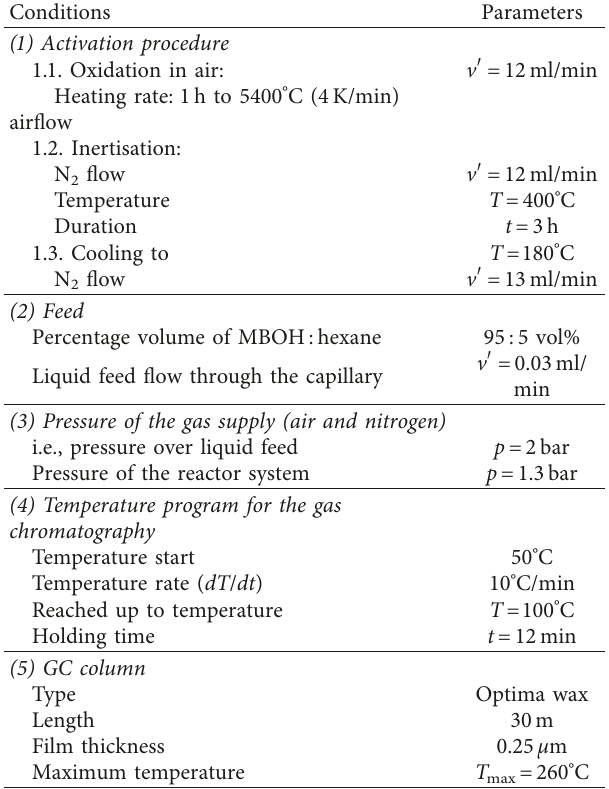
Table 3: Collected conditions and parameters for the temperature- programmed desorption of ammonia analysis, over natural zeolite [95].